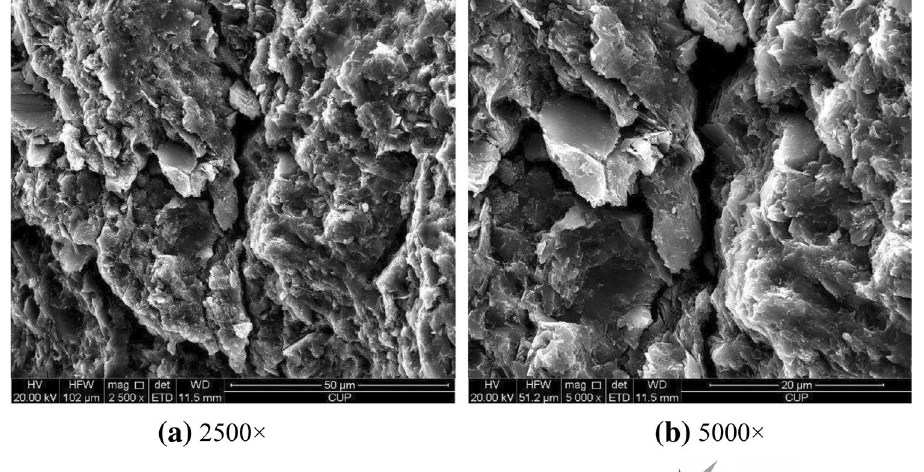
Fig. 15 SEM images of dried shale after LN 2 cooling (Cai et al. 2014). a × 2500, b ×